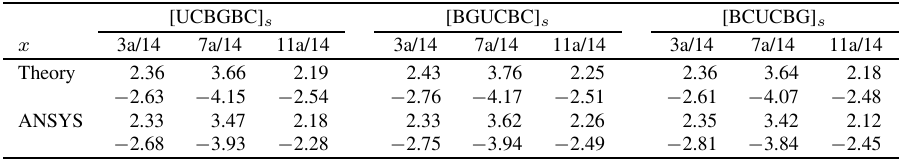
Table 3 The positive and negative peak values of displacements for β = 1.2 (mm)